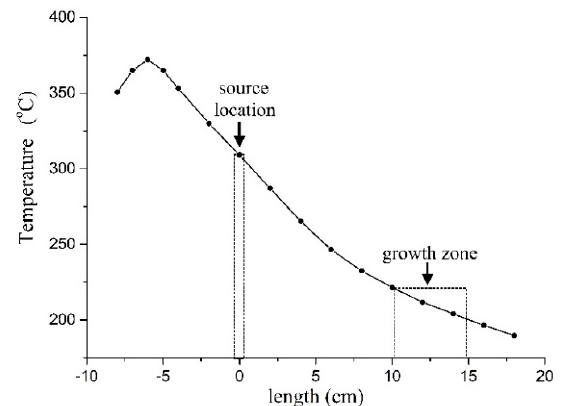
Figure 1. Temperature profile inside the quartz growth tube with the specified positions of the substance source and the p-quinquephenyl crystals growth zone.